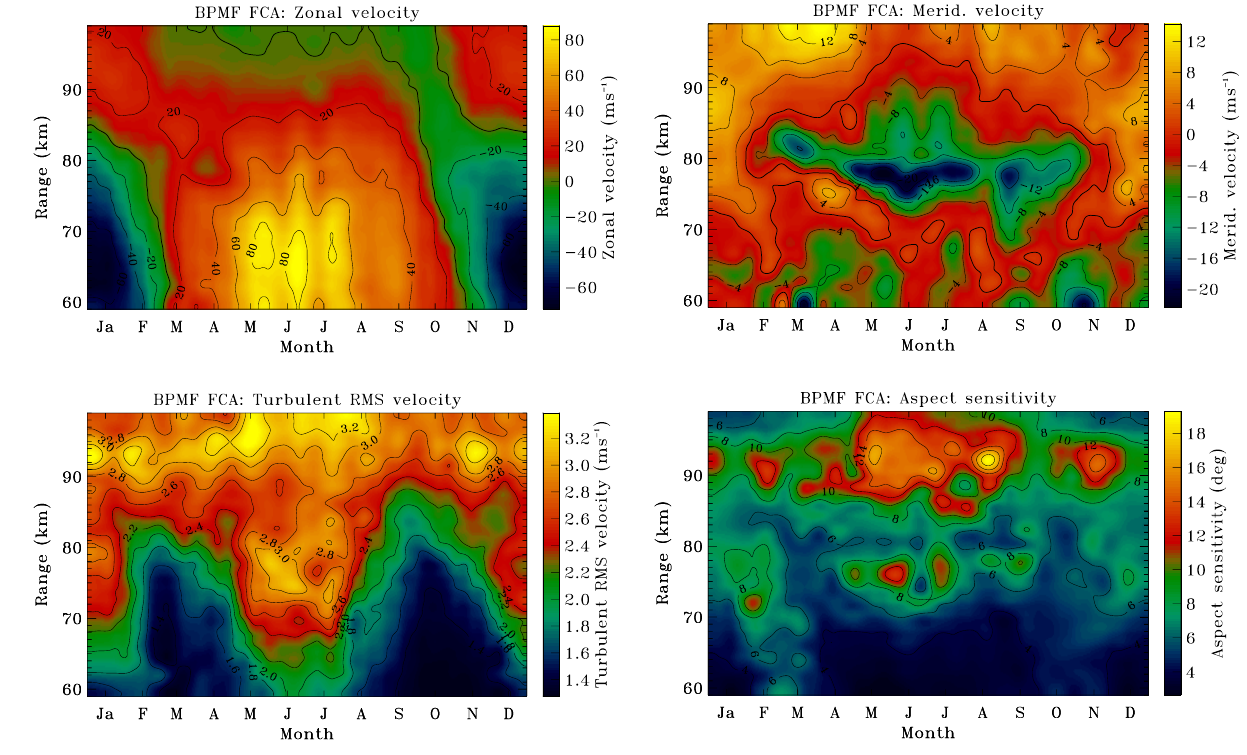
Fig. 6. Superposed annual variation of BPMF FCA parameters zonal velocity (top left), meridional velocity (top right), turbulent RMS velocity (bottom left), and aspect sensitivity (bottom